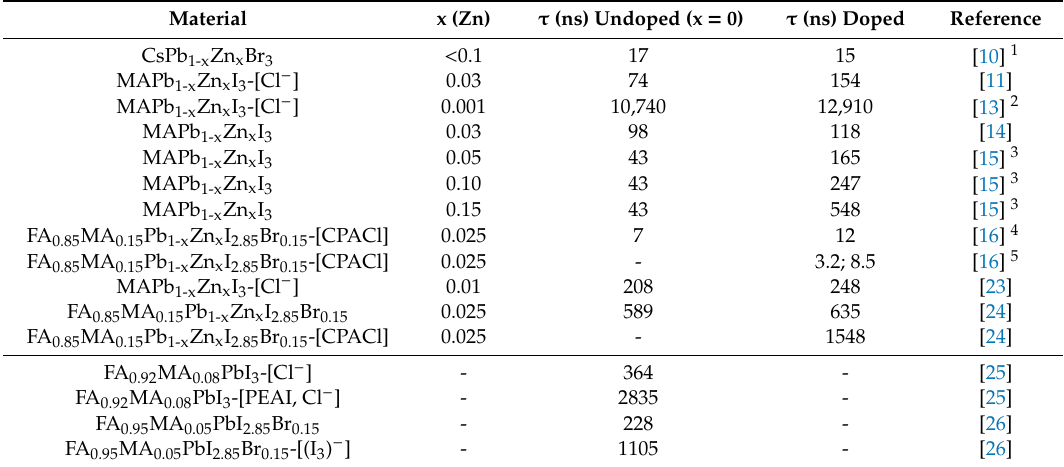
Table 1. Photoluminescence lifetimes of di ff erent undoped and Zn(II) doped perovskite materials on glass or quartz (unless indicated). Additives are indicated in square